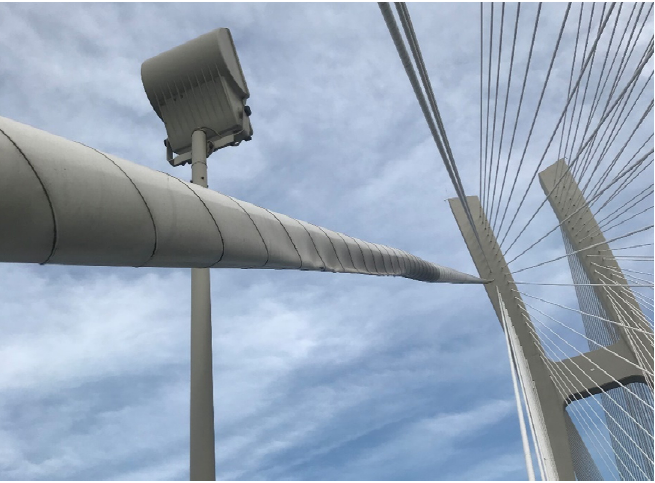
Figure 22. LZ-W11 cable sheath deformed as a result of a vehicle fire.